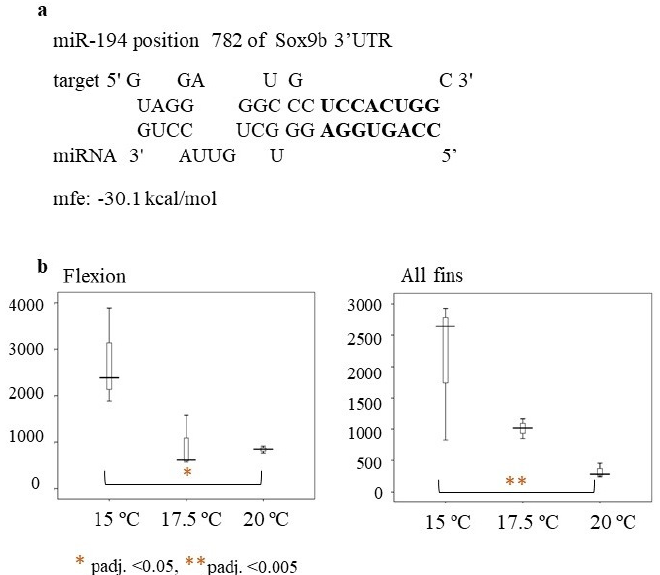
Figure 10. ( a ) Hybridization of miR-194 to Sox9b (ENSDLAT00005040776) of the European sea bass ( b ) Box-whisker plot of miR-194 relative expression at the flexion and all-fins stage. On the y-axes are the number of read counts. Significant differences are indicated by a red asterisk as follows: * = padj. < 0.05 ** = padj. < 0.005. Additionally, after performing a knockout of the two GnRH genes in zebrafish, a function of GnRH on the brain, eye, and heart development was demonstrated [47]. Knockout of the gnrh3 gene in zebrafish leads to an increase in sox9a , amh , and cyp11b gene expression, favoring maleness [48]. This finding, together with the fact that miRNAs targeting the GnRH receptor pathway were differentially expressed at the all-fins stage in the present study, may lead to the assumption that GnRH could also be involved in the sex-differentiation process of European sea bass at an early developmental stage. Additional studies will be needed to investigate the specific role of GnRH in sex differentiation and the effect of temperature on its function. 4. Materials and Methods 4.1. Ethics Approval Ethical approval for the study was obtained by the relevant Greek authorities (National Veterinary Services) under license No 255368. All procedures involving animals were conducted following the “Guidelines for the treatment of animals in behavioral research and teaching” [49], the ethical justification for the use and treatment of fishes in research: an update [50], and the “Directive 2010/63/EU of the European Parliament and the Council of 22 September 2010 on the protection of animals used for scientific purposes” (EU 2010). 4.2. Sampling European sea bass eggs were collected on 14 February 2018, from a private fish farm in Sitia, Crete, Greece, and transferred to the aquaculture facilities of HCMR in Heraklion for larval rearing. Around 50,000 eggs were placed in each of six 500 L tanks (initial density of 100 individuals L − 1 ), and developing larvae were reared until full metamorphosis at three different temperatures, 15, 17.5, and 20 °C, in duplicate tanks.